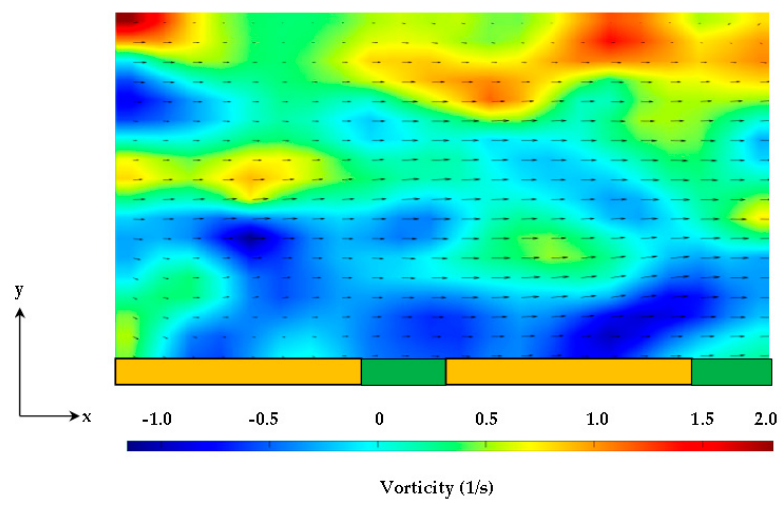
Figure 25. Vorticity contours of 10 µm diameter fl uorescent particles at 4 A and 10 Hz.